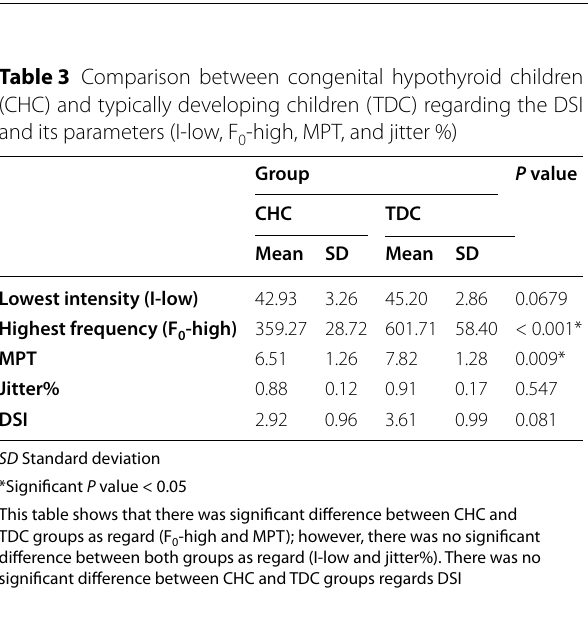
Table 5 Comparison between males and females in congenital